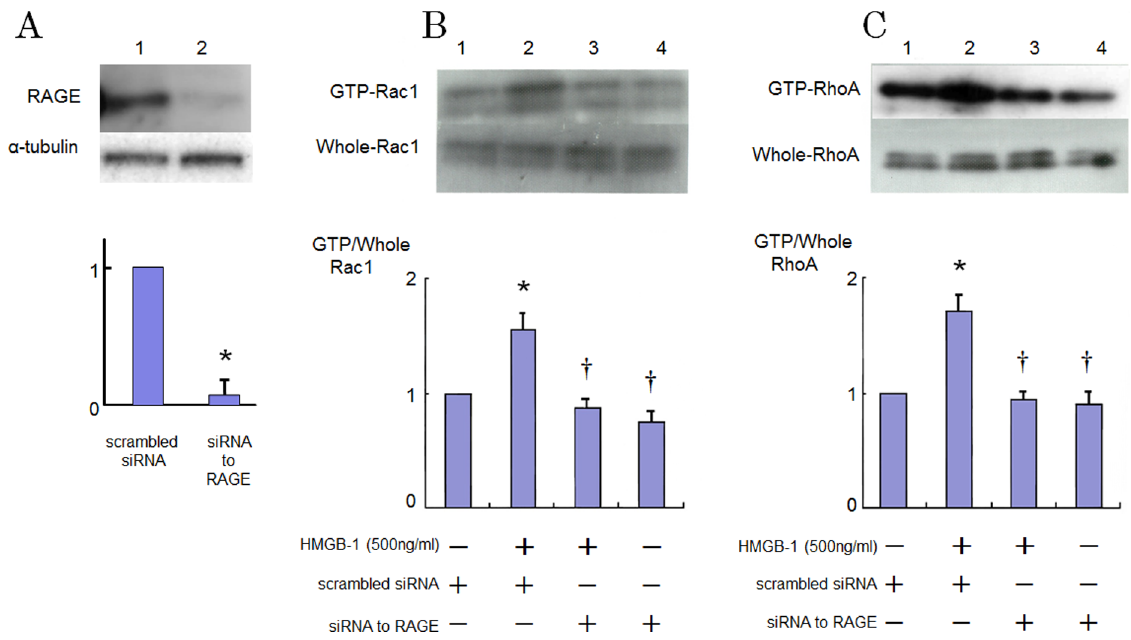
Fig. 3. Effects of inhibition of RAGE with siRNA on increased GTP-loading of RhoA and Rac1 caused by HMGB-1 in HAECs. (A) Effect of knockdown of RAGE by siRNA on the RAGE protein level as determined by western blotting. Bars are mean ¡ S.D. of quantitative densitometric analyses from 3 separate experiments. Representative immunoblots from 3 independent experiments are shown. * P , 0.05 vs. Lane 1. (B and C) Cells were incubated in the presence of HMGB-1 with or without transfection with siRNA to RAGE. Bars are mean ¡ S.D. of 4 separate experiments. Representative immunoblots from 4 separate experiments are shown. * P , 0.05 vs Lane 1; { P , 0.05 vs. Lane 2.